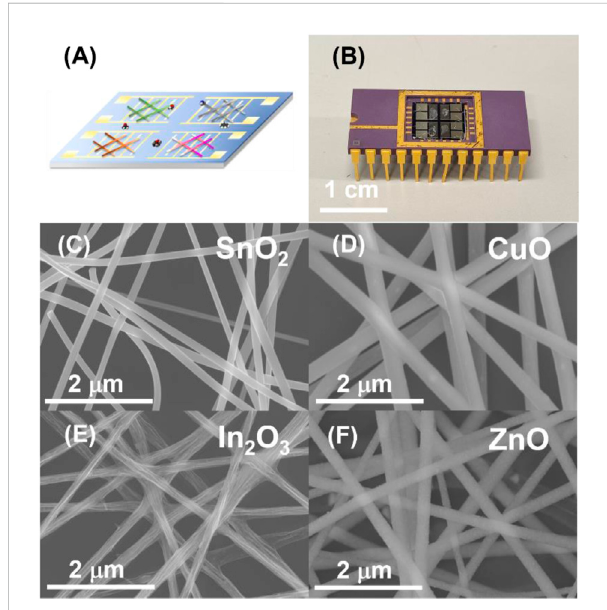
FIGURE 2 Morphological characterization of the four gas sensor array by SEM. (A) Conceptual image of the four gas sensor array with various gas analytes. (B) Photo image of four gas sensor array mounted on a DIP chip carrier by wire bonding. SEM image of the four electrospinning nano fi bers gas sensors (C) : SnO 2 , (D) CuO, (E) In 2 O 3 and (F) ZnO, respectively).